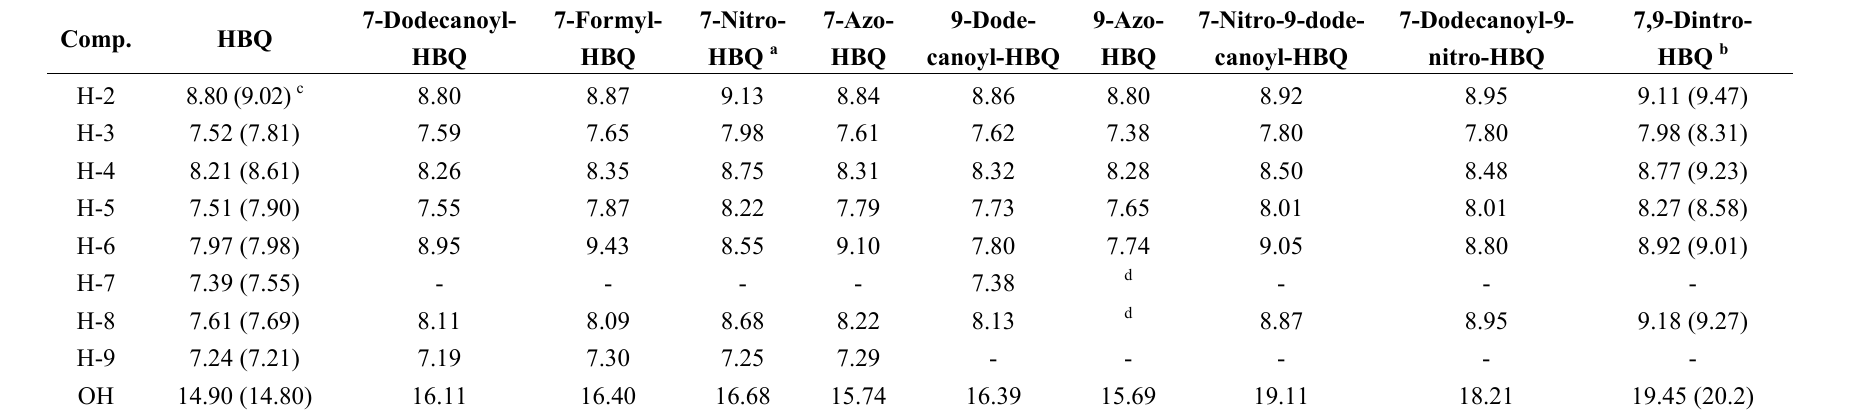
Table 2. 1 H-NMR chemical shifts in ppm. Solvent CDCl